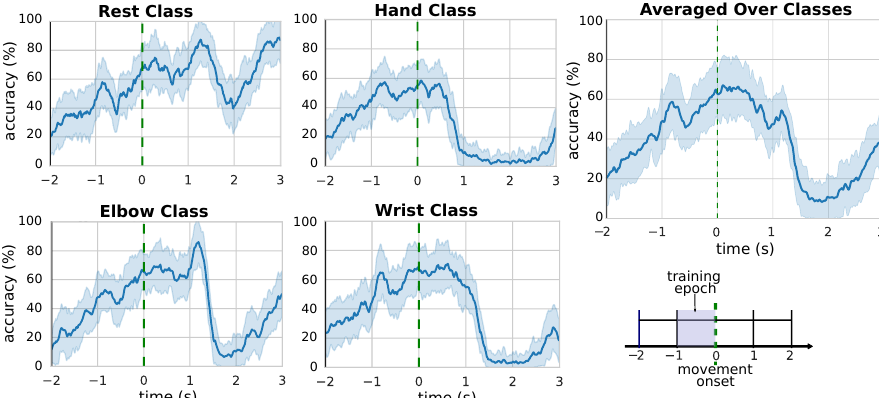
Figure 4. Accuracy of the model, at each timestep, in the time segment around the detected movement onset, for the different movement classes. The trials have all been synchronized at the actual movement onset ( t = 0), denoted by the green dashed line (see Section 2.1). The figure in the bottom-right corner describes the structure of the trials (see Section 2.1) at t In the experiments, the model is trained only using the 1-second segment preceding the movement